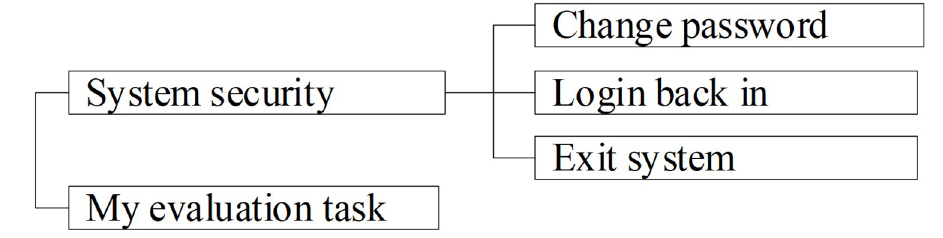
Fig 5. Function modules of